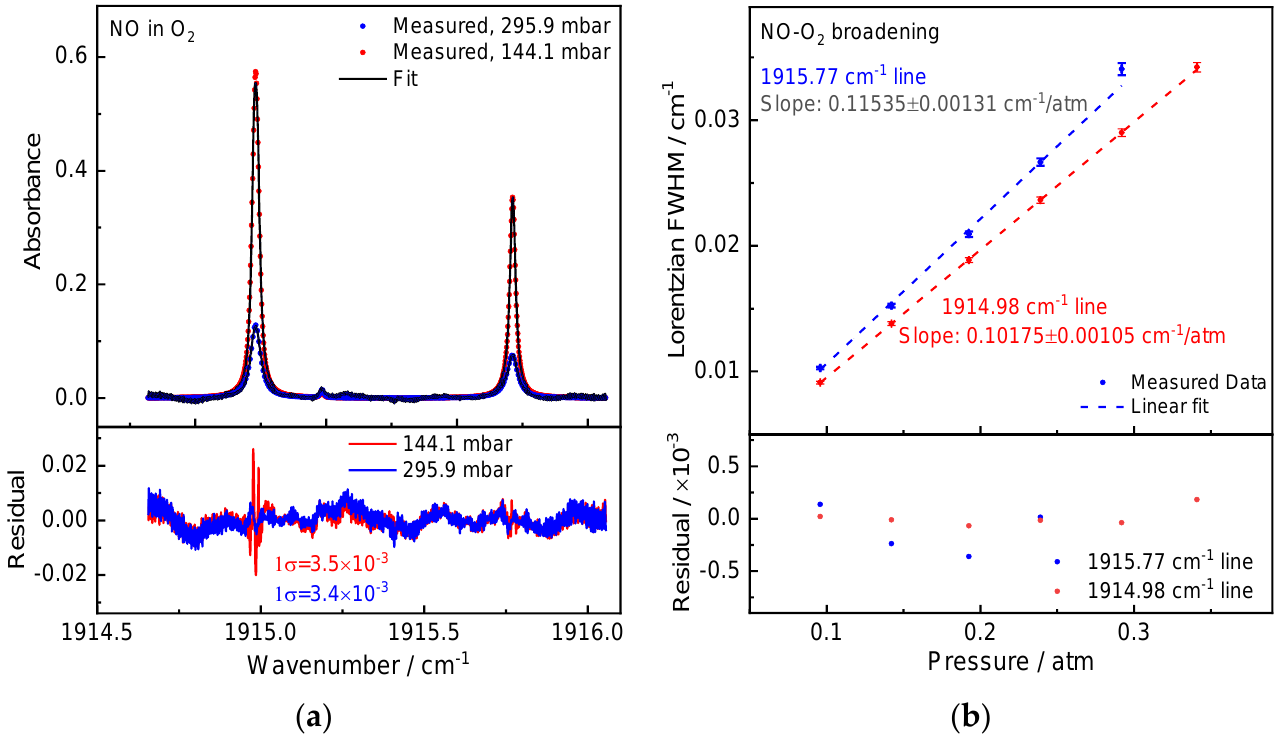
Figure 5. ( a ) Measured NO absorption spectra (20-scan average) in O 2 at pressures 144.1 mbar and 295.9 mbar. Below is a display of the residual between the measured and fitted values. ( b ) Obtained NO P(5) (1 ← 0) pressure broadening absorption line caused by O 2 and fitted with a linear model. Below is a display of the fit-to-data residual.